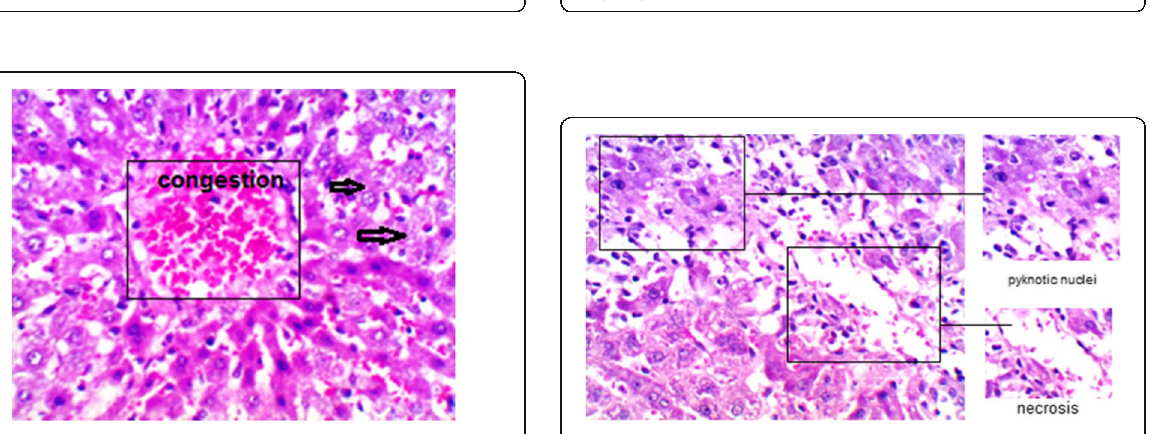
Fig. 3 Photomicrograph of the control liver showing minimal amount of connective tissue around the portal area (Masson ’ s trichrome ×200)